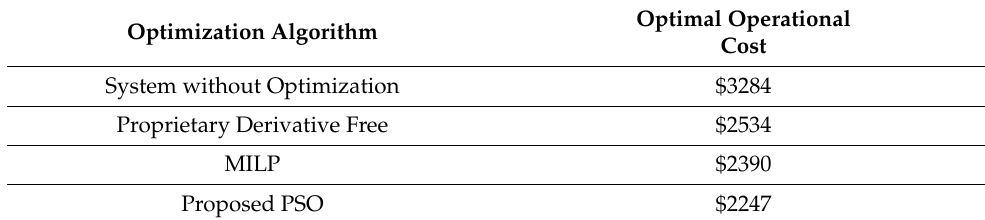
Table 5. Comparison of Different Optimization